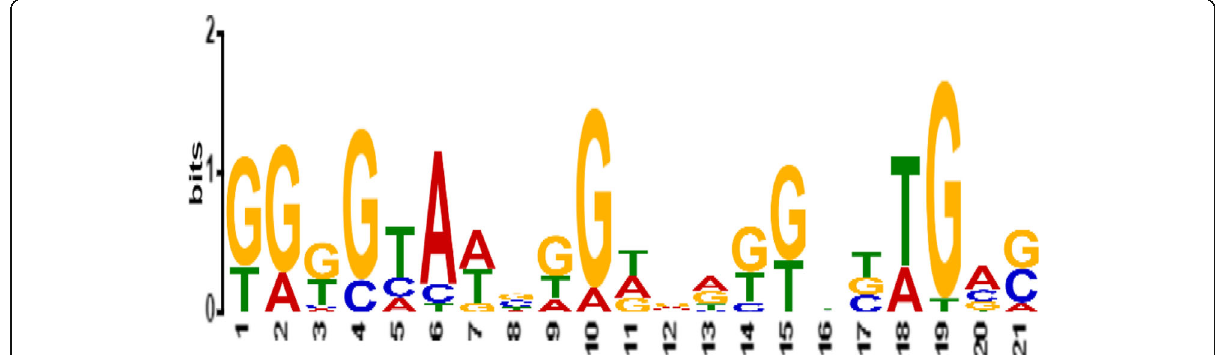
Fig. 2 Sequence logo for the identified common motif M β GII for glucan endo-1,3-beta-glucosidase genes of Solanum tuberosum cultivar DM1-3 156